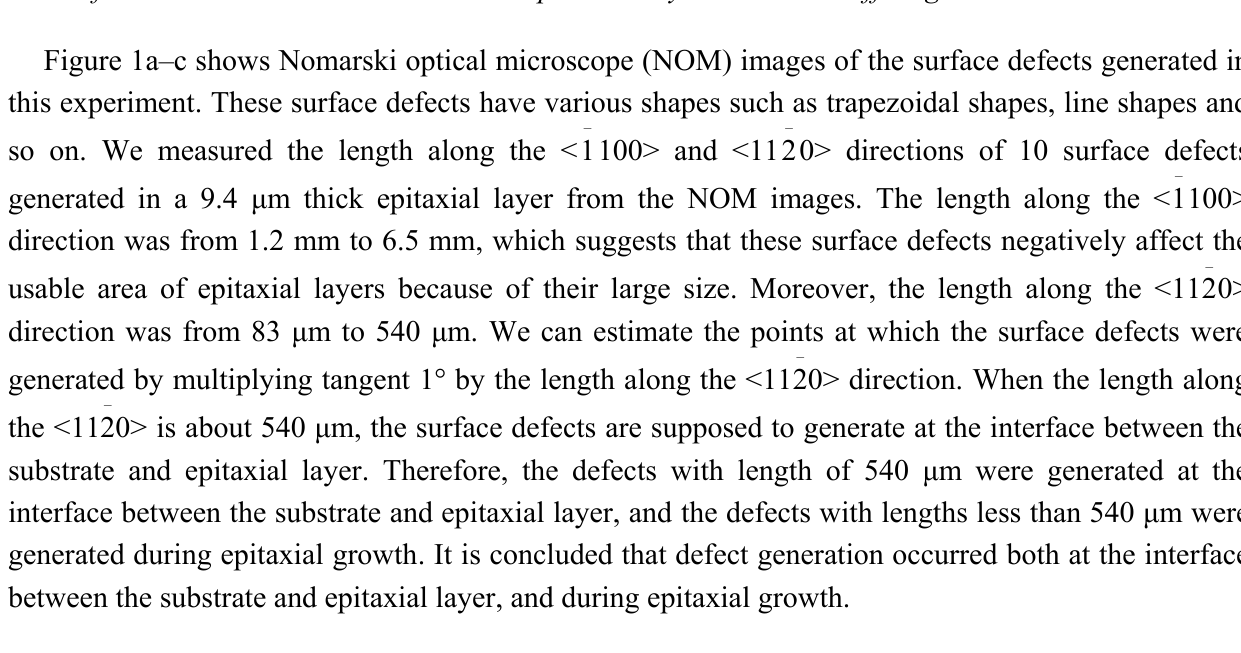
Figure 1. ( a – c ) Nomarski optical microscope (NOM) images of surface defects generated in 4 H -SiC Si-face epitaxial layers with a 1°